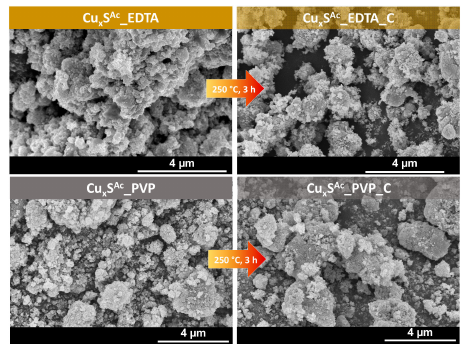
Figure 2. SEM micrographs of the obtained Cu x S samples prepared using Cu(OOCCH 3 ) 2 · H 2 O as the precursor and di ff erent stabilizing agents (EDTA or PVP). The heat-treated samples (250 ◦ C, 3 h) are also